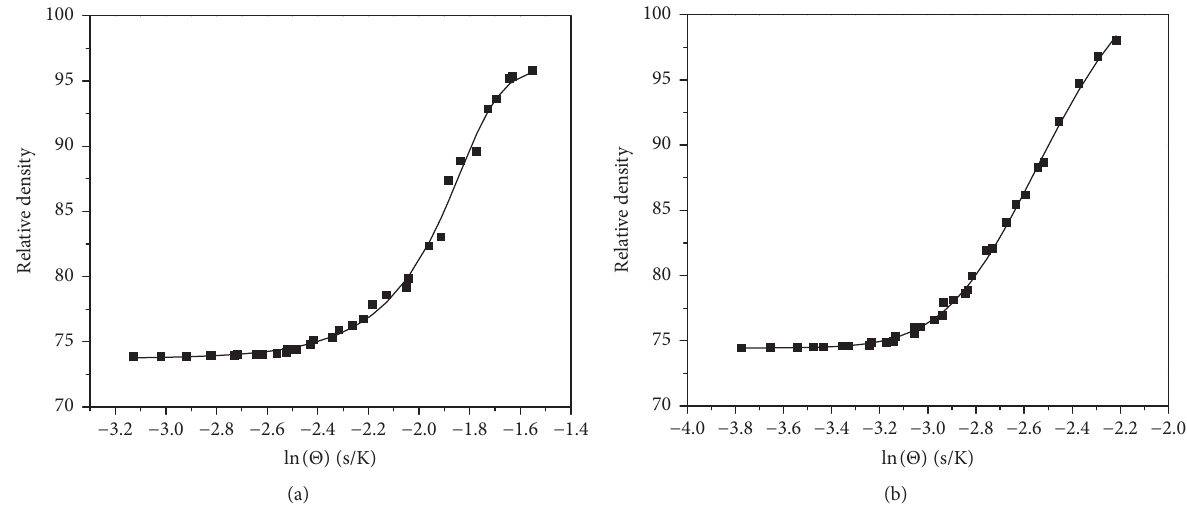
Figure 5: Master sintering curves: (a) sintering temperature of 400 ∘ C, pressure of 50 MPa, and holding time of 30 min; (b) sintering temperature of 500 ∘ C, pressure of 50 MPa, and no holding time.